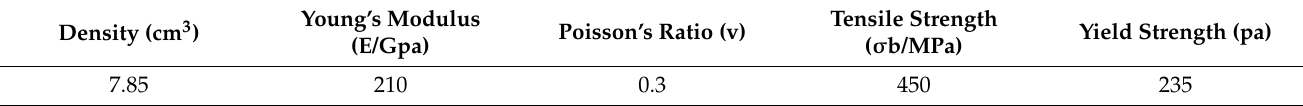
Table 1. Parameters of the steel frame material model of the roof.